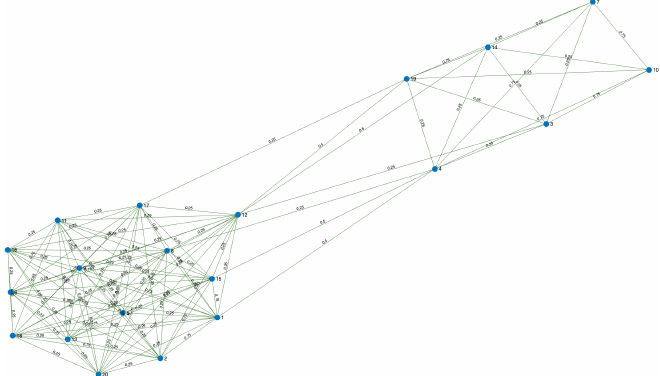
Figure 2. Graph obtained from D